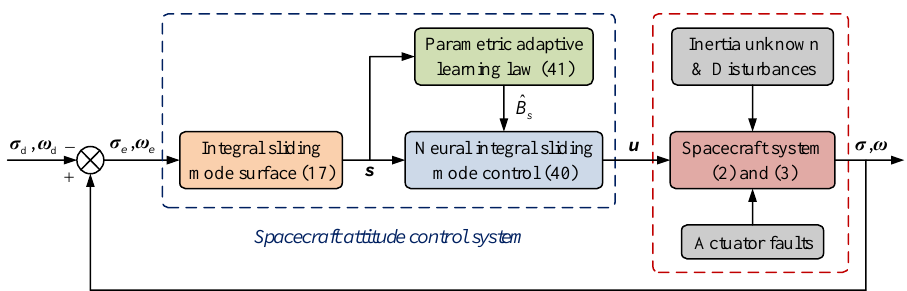
Figure 1. Structure of the proposed neural integral sliding mode control strategy.